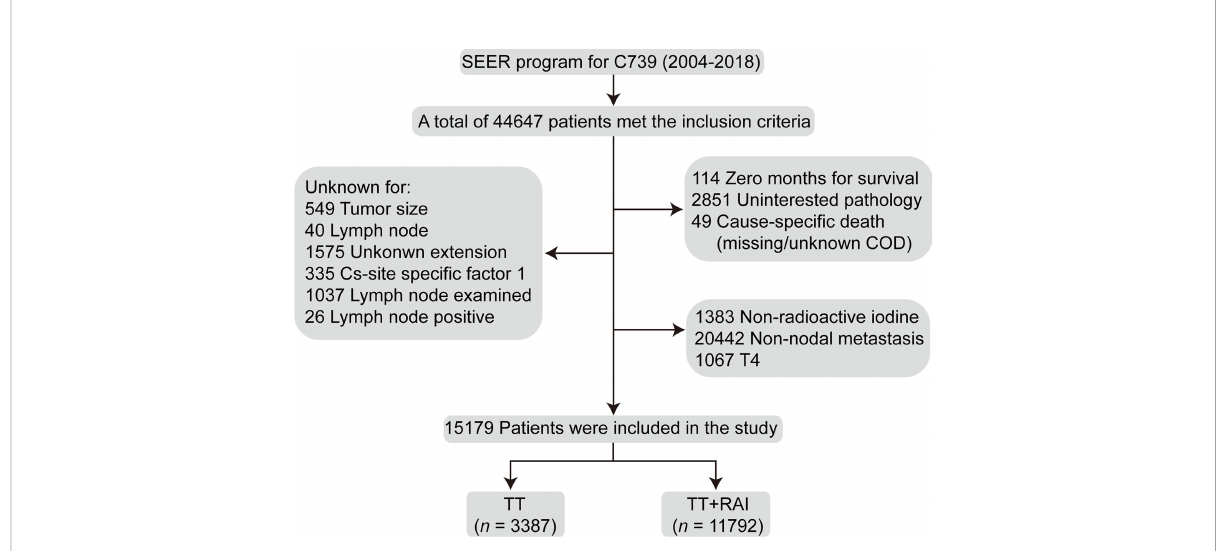
FIGURE 1 Flowchart of the selection process of the patients who underwent TT and additional RAI treatment from the Surveillance, Epidemiology, and End Results database. TT, total thyroidectomy; RAI, radioactive